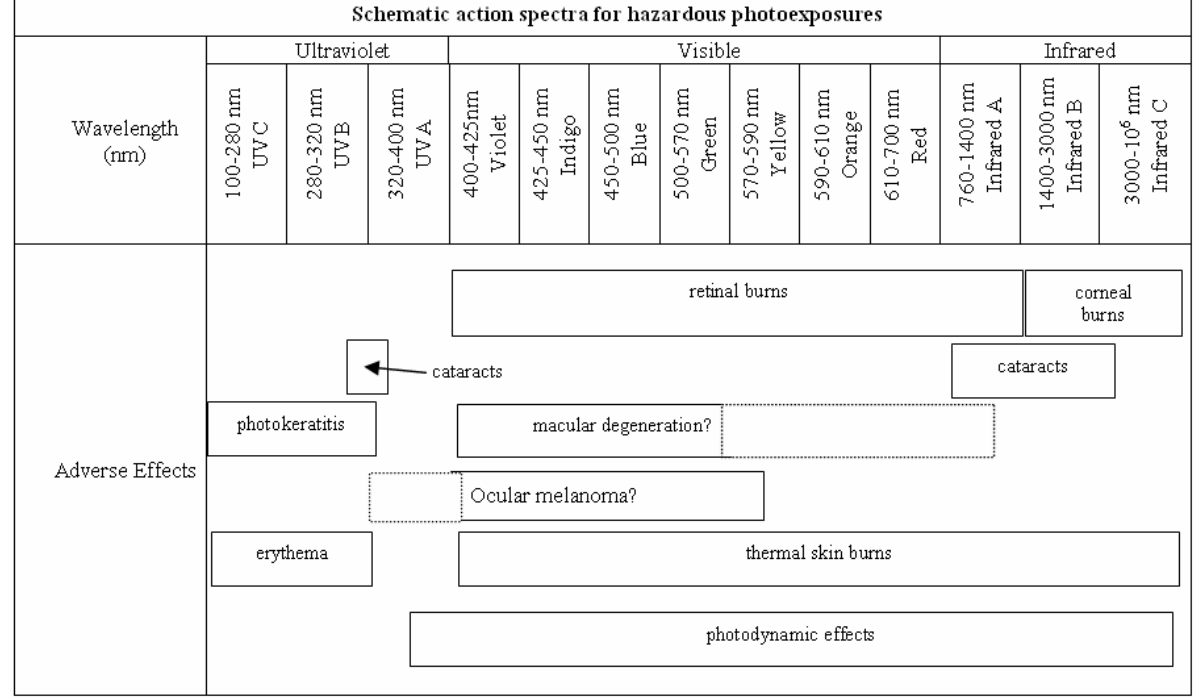
Figure 10: Schematic action spectra for hazardous photoexposures